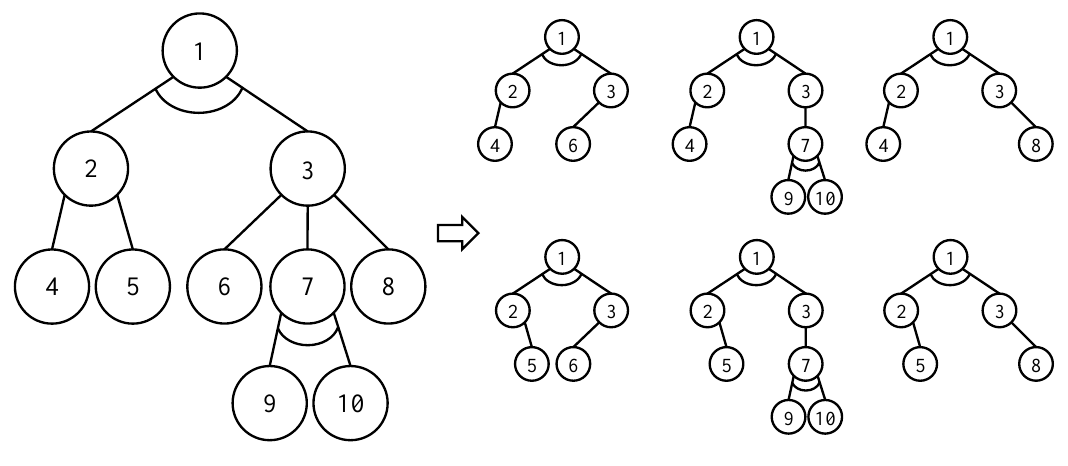
Figure 2. An AND/OR tree and all its